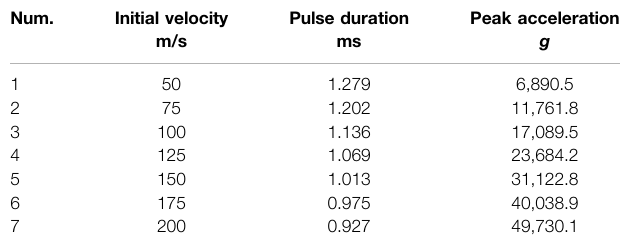
TABLE 3 | Statistics of impact load information.